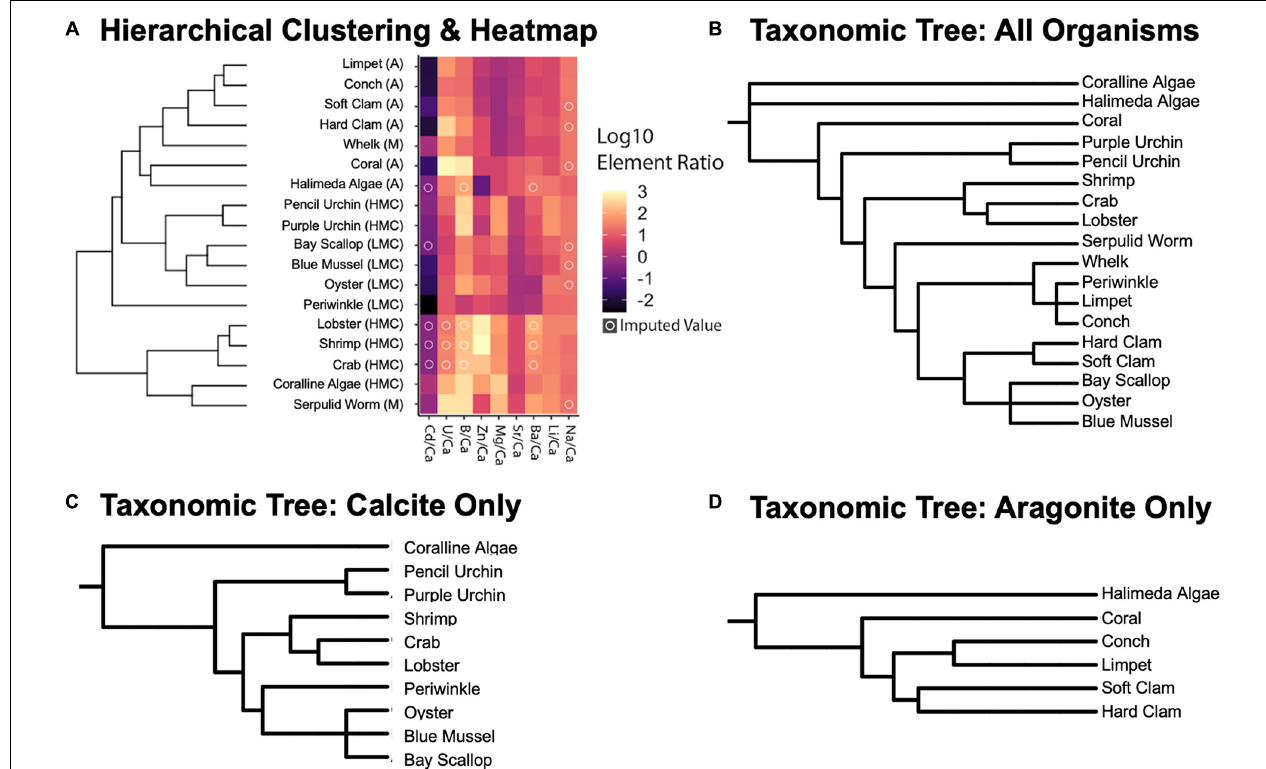
FIGURE 4 | (A) Hierarchically clustered (Bray-Curtis dissimilarity) heatmap of log10 values of element to calcium ratios separated by species. Letters in ellipses correspond to organism biomineralogy: A, aragonite; HMC, high Mg calcite; LMC, low Mg calcite; and M, mixed. Lighter colors indicate higher values from log10-transformations of elemental ratios, and an “O” on top of a pixel indicates that the value was imputed using a K-Nearest Neighbors model estimation (see section “Materials and Methods” for details). (B–D) Taxonomic trees of the studied organisms based on genetic similarity/difference for all, calcitic, and aragonitic species, respectively. Taxonomic trees were built using the phyloT application based on the NCBI taxonomic backbone (see section “Phylogenetic Analyses”; Letunic and Bork, 2019). Qualitative similarities between the resulting dendrogram of the clustering analysis and the mineral-specific taxonomic trees suggest that taxonomic patterns arise in the elemental ratio measurements but are potentially convoluted by mineralogical